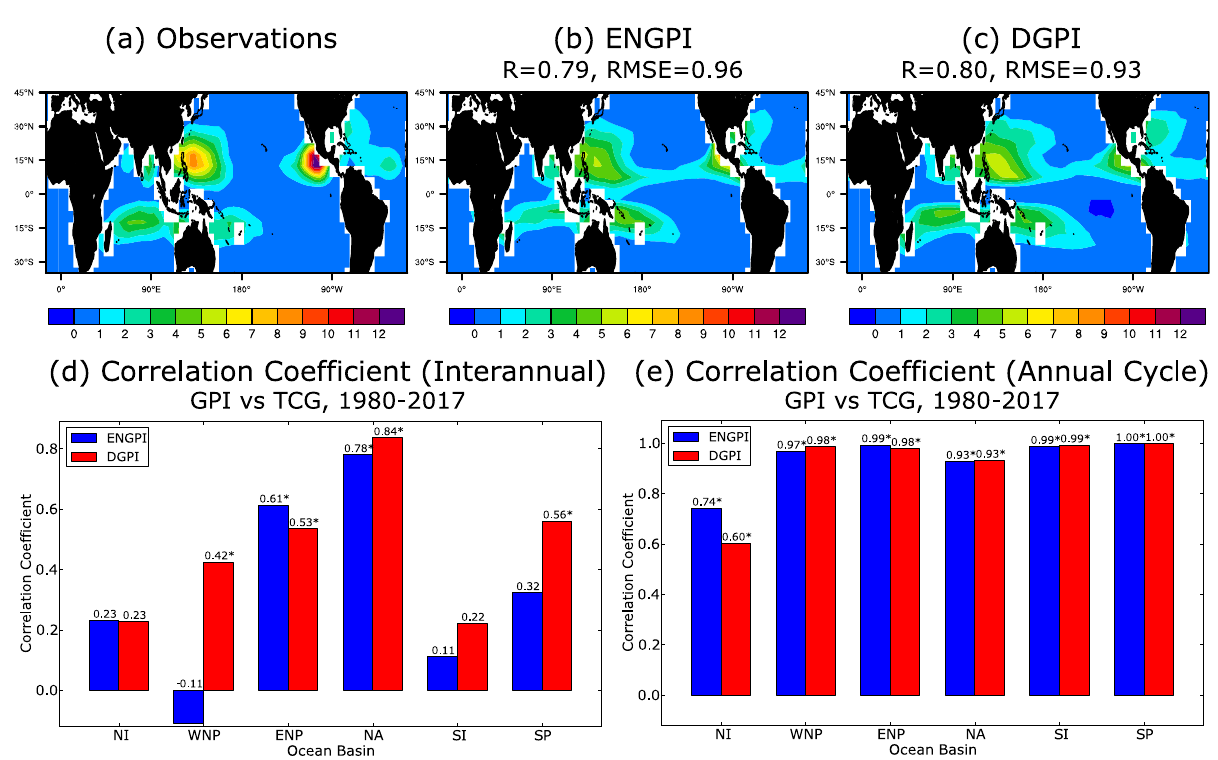
Fig. 1 Performance of ENGPI and DGPI in diagnosing the climatology, interannual, and seasonal variability of TCG frequency. The upper panels are the climatological annual mean TCG frequency in the observation ( a ) and the TCG potentials computed using ENGPI ( b ) and DGPI ( c ). Units are 0.1 × number per 5° × 5° grid cell per year. The spatial PCC and RMSE from the observed TCG frequency are shown at the top of the corresponding panels for ENGPI and DGPI. Panel ( d ) presents the interannual correlation coef fi cients between TCG frequency and the TCG potential computed by ENGPI (blue) and DGPI (red) in the six ocean basins: North Indian (NI); western North Paci fi c (WNP); eastern North Paci fi c (ENP); North Atlantic (NA); South Indian (SI); and South Paci fi c (SP). e As in ( d ), but for the 12-month climatological annual cycle. The ensemble mean dataset, derived from the fi ve reanalysis datasets during 1980 − 2017, is used to compute the